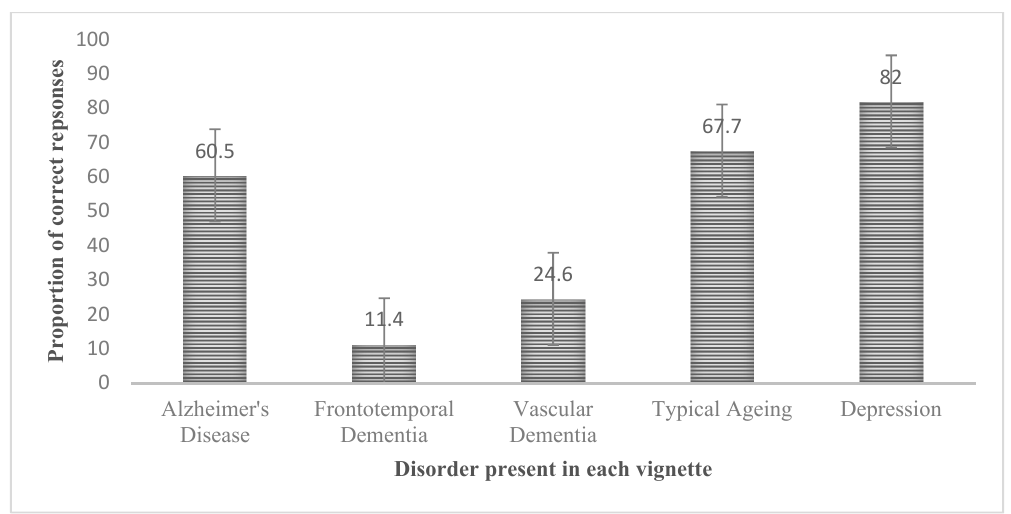
Figure 1. The percentage of correct responses to the five vignettes (error bars show standard error).